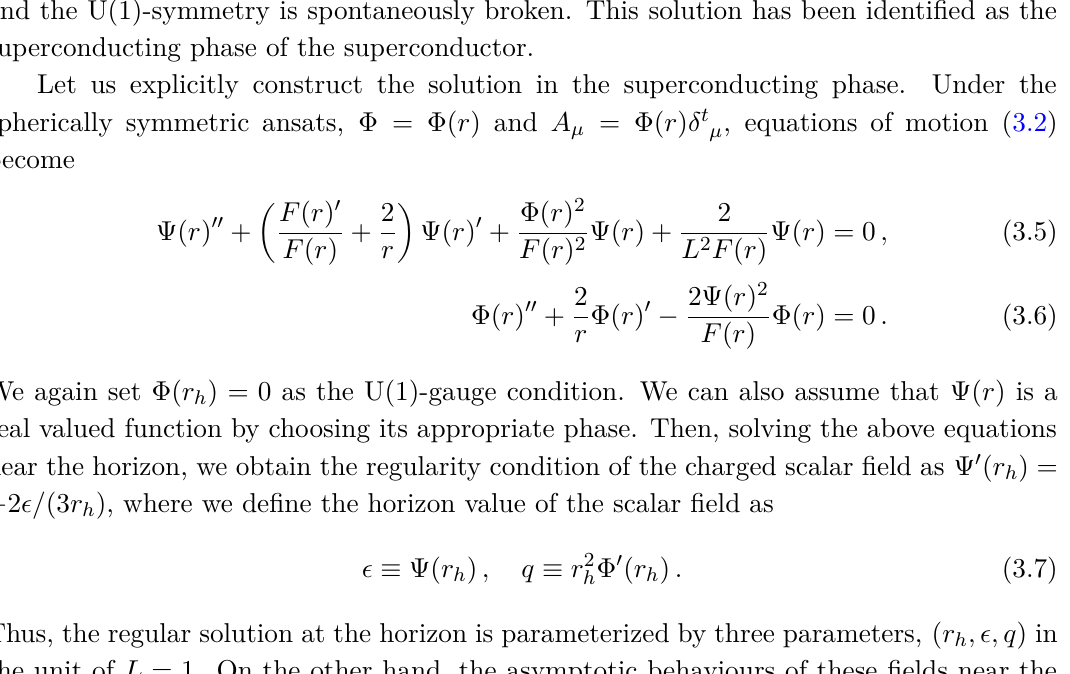
Figure 6 . Ψ (2) ( (cid:15) ) for r h = 0 . 1 , 0 . 3 , 1 . 0 . Figure 7 . µ ( (cid:15) ) for r h = 0 . 1 , 0 . 3 , 1 . 0 . the normal mode to a nonlinear regime. Such a solution has the charged scalar